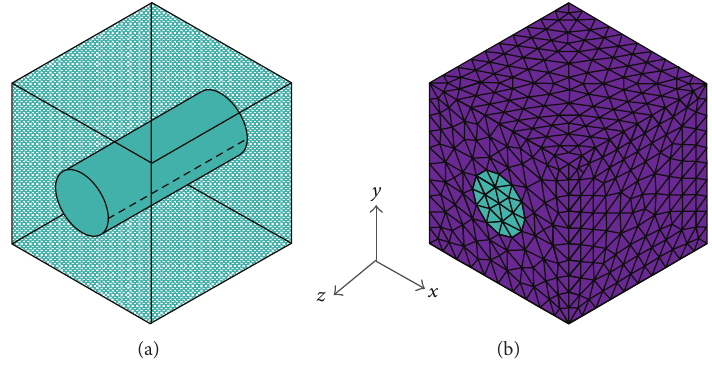
Figure 7: (a) Geometry and (b) meshing of the RVE.